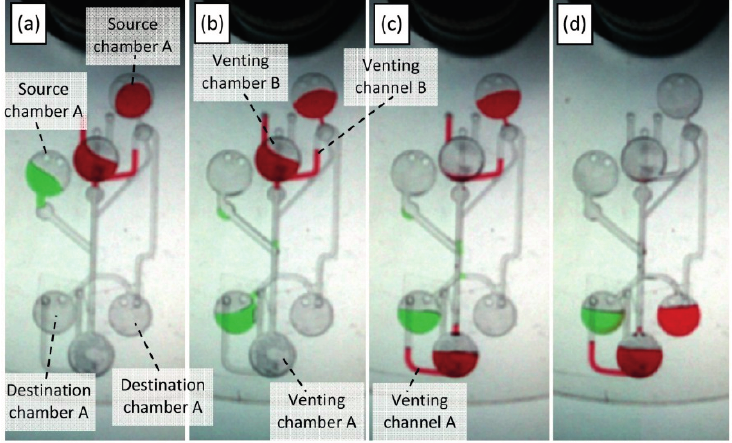
Figure 6. Photos of the microfluidic switching process at various stages ( a ) spinning speed less than 250 RPM where all liquids at its original positions, ( b ) source chamber A liquid bursts towards destination chamber A at 260 RPM, ( c ) venting chamber B liquid bursts towards venting chamber A at 300 RPM, and ( d ) source chamber B liquid bursts towards destination chamber B at 370